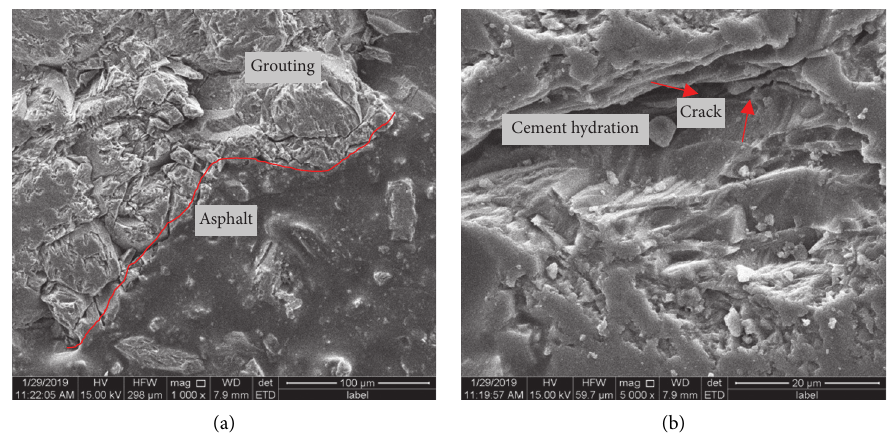
Figure 19: Morphology of SFP sample cured for 5 days. (a) Scale bar � 100 μ m. (b) Scale bar � 20 μ